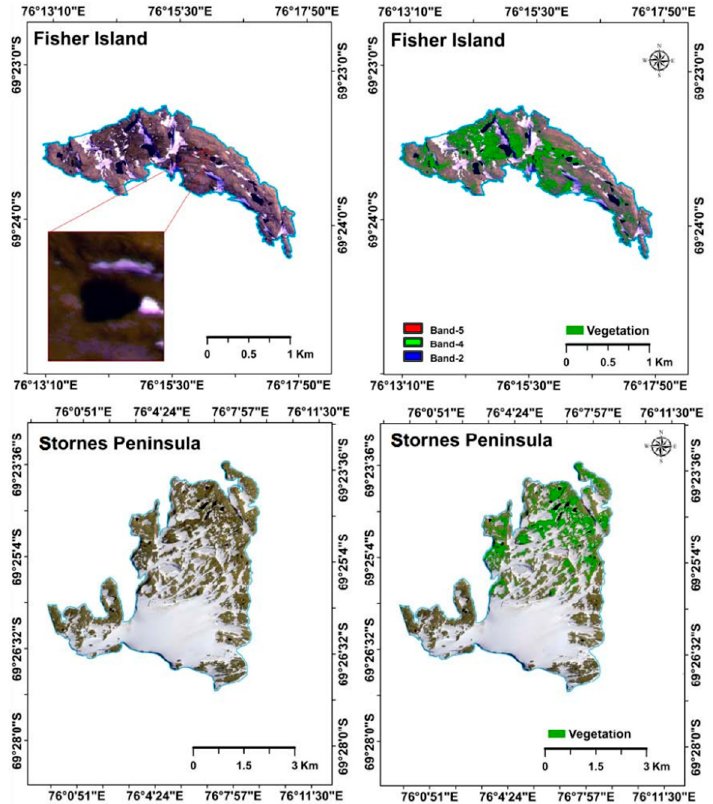
Figure 2. Reference manually digitized maps of Fisher Island and Stornes Peninsula showing the spatial distribution of vegetated areas which includes dead black vegetation, healthy green, stressed yellow, and brown vegetation in wet areas. A sample of greenish yellow vegetation is highlighted with a red colored box in top left panel. All the displayed maps were prepared using Band-5 (630–690 nm), Band-4 (585–625 nm), and Band-2 (450–510 nm) of WorldView-2 (WV-2) imagery.